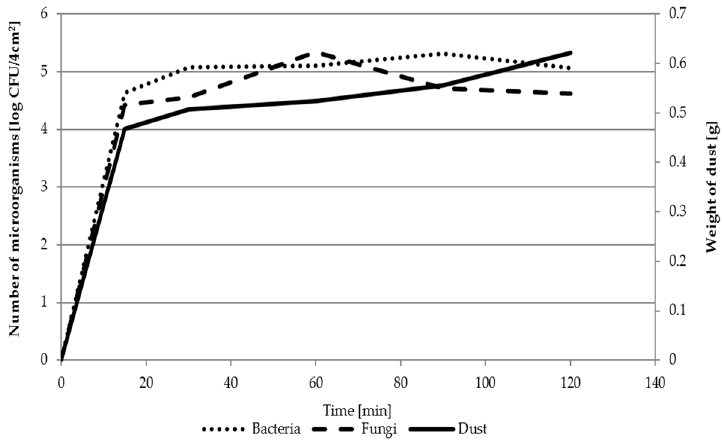
Figure 3. Dynamics of changes in the number of microorganisms and the amount of dust on the FFRs during their use at the combine operator’s workplaces.